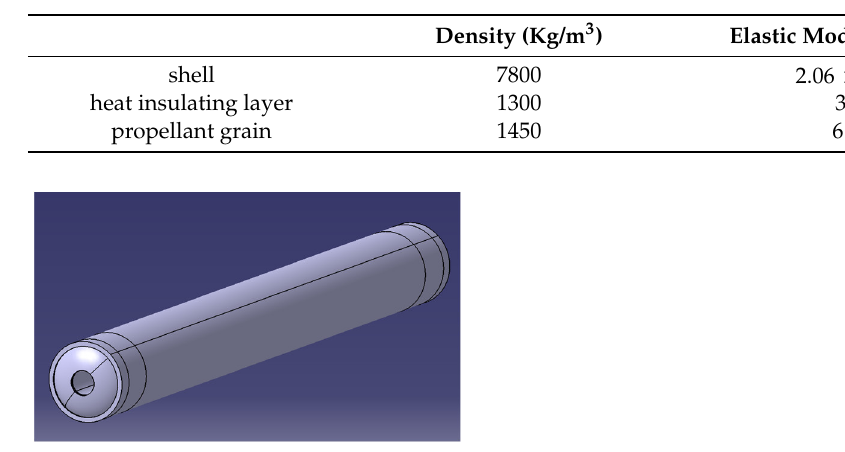
Table 1. Material parameters of rocket engine shell.